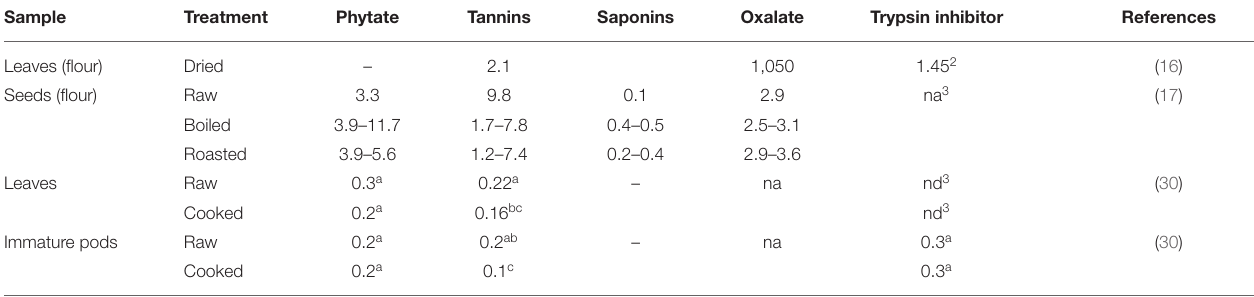
TABLE 4 | Anti-nutrient contents in mg/100 g 1